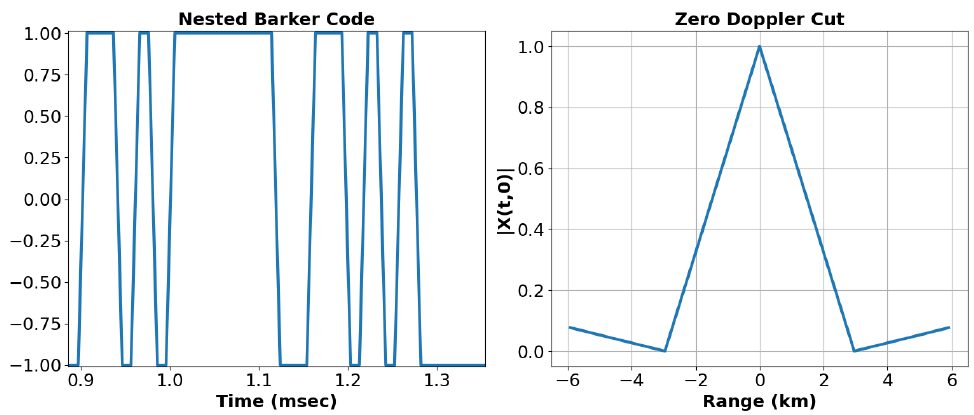
Figure 6. Part of the Nested Barker Code ( left ) and zero cut of AF ( right